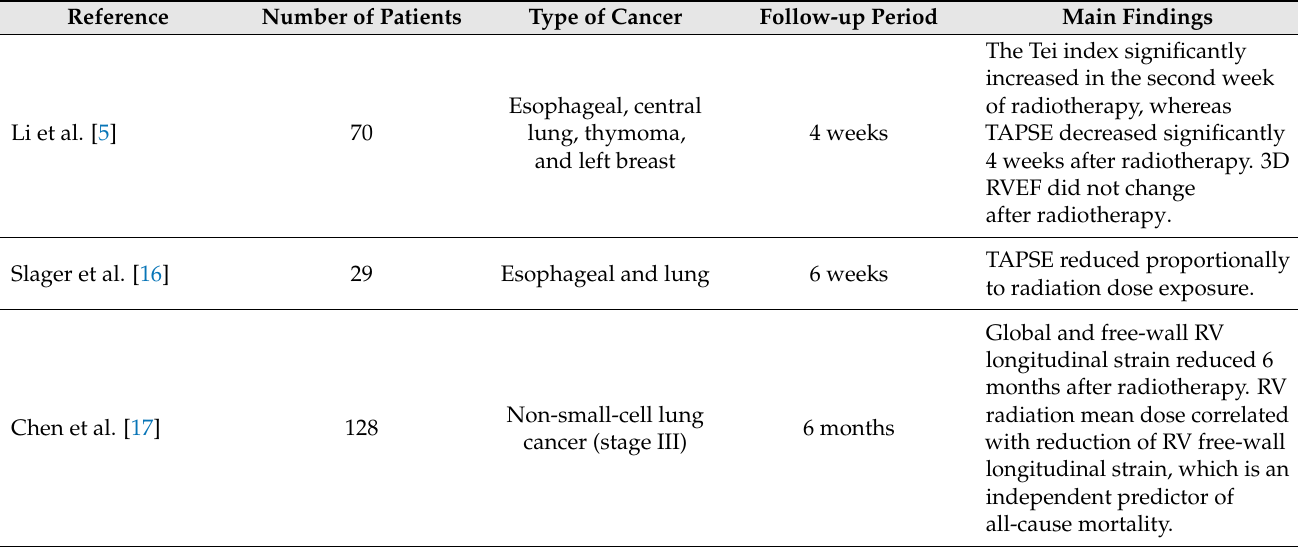
Table 3. RV remodeling in patients with thoracic cancer who received